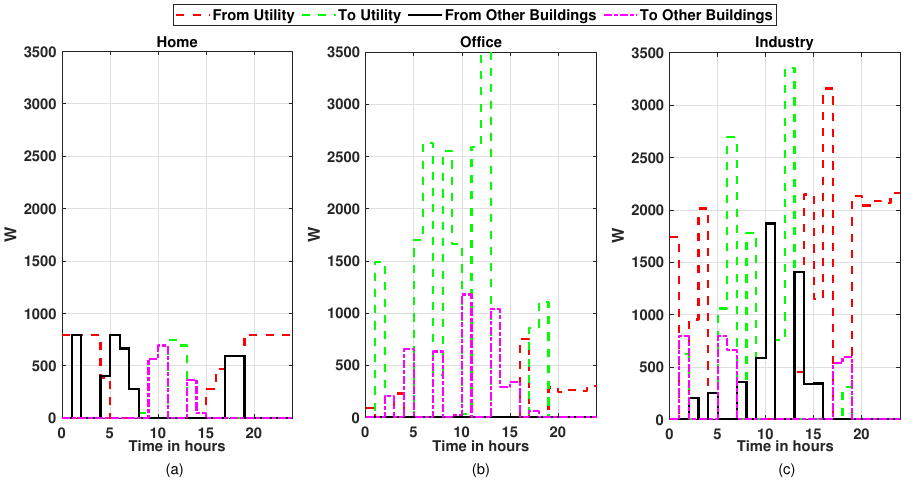
Figure 11. Electricity cooperation among the buildings for 24 h in the month of June, ( a ) for the home building, ( b ) for office building, and ( c ) for industry